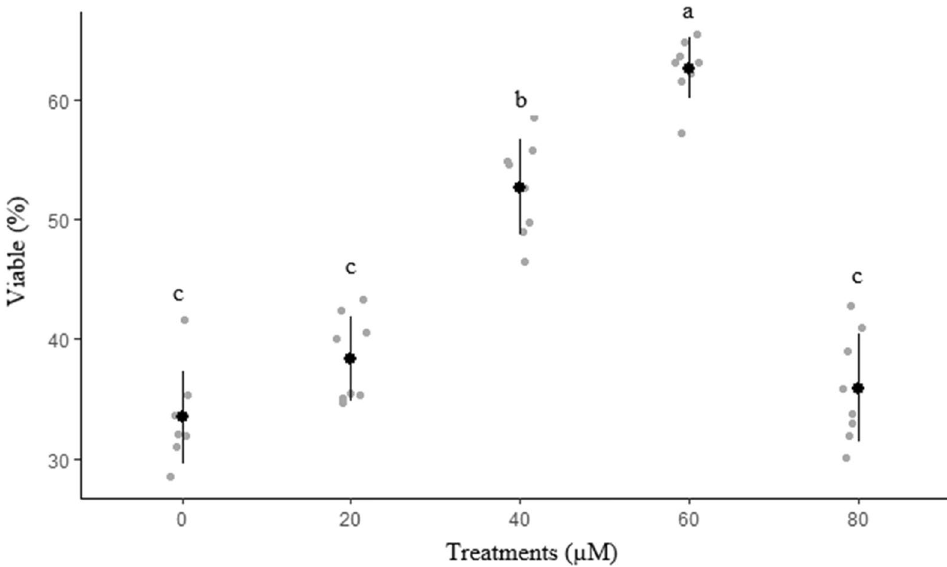
Figure 8. Effect of different levels of rosiglitazone on viability of ram thawed sperm.